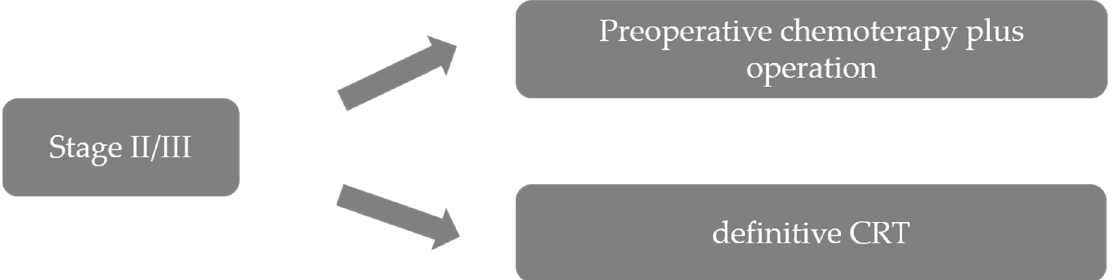
Figure 1. Treatment strategies for stage II/III ESCC, adapted and modified from guidelines of the Japan Esophageal Society. ESCC, esophageal squamous cell carcinoma; CRT, chemoradiotherapy.